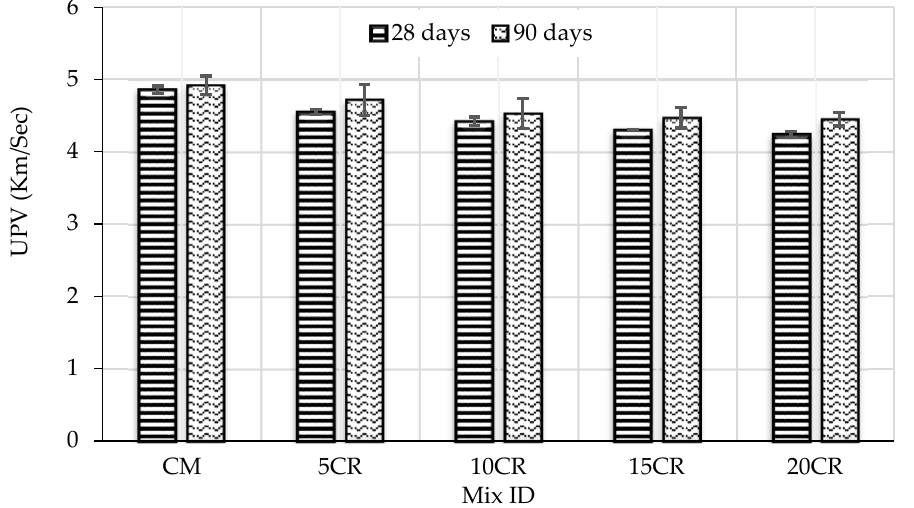
Figure 15. Ultrasonic pulse velocity results.